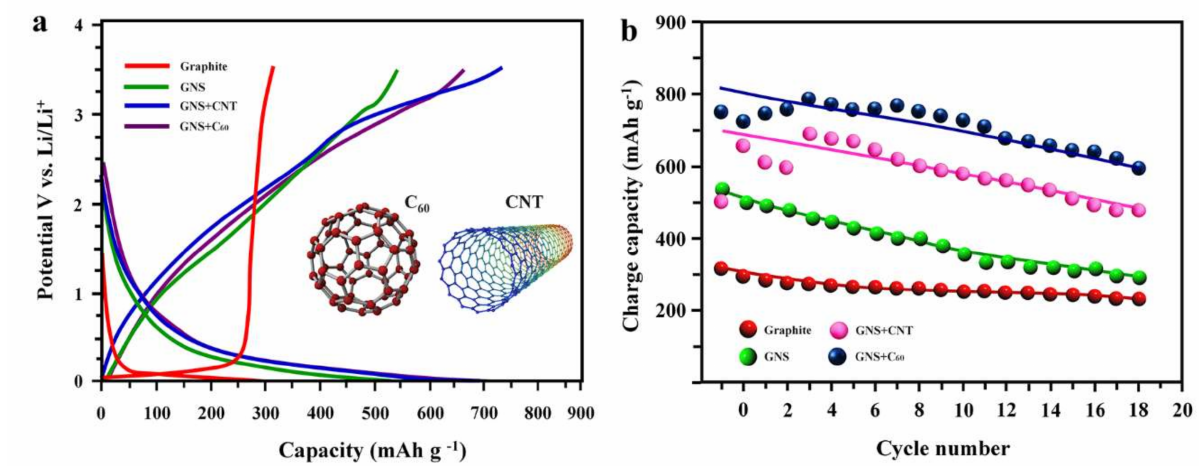
Figure 7. Charge–discharge profiles and cycle stability of the graphite, graphene (GNS), GNS + carbon nanotube (CNT), and GNS + Fullerene (C 60 ); ( a ) charge/discharge curves at 0.05 A g − 1 , ( b ) comparison of cycling performance. Adapted and reproduced with permission from [32]. Copy- right 2008 American Chemical Society.